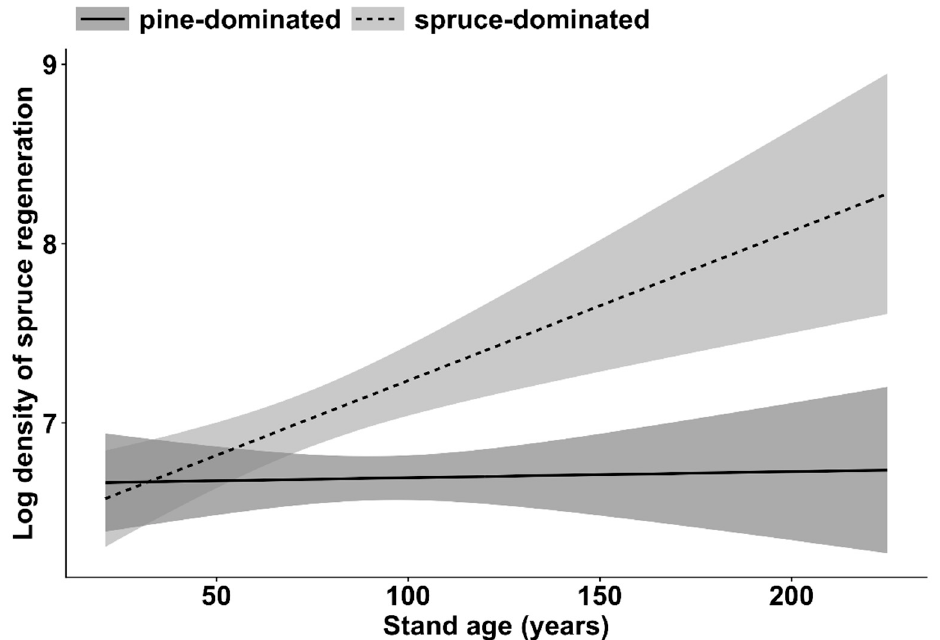
Figure 7. The influence of stand age on the density of advance regeneration of Norway spruce in Scots pine and Norway spruce-dominated stands. The grey area represents a ±95% confidence interval.